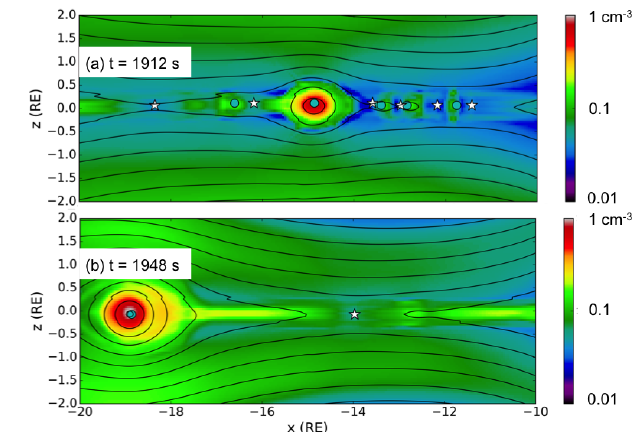
Figure 4. Plasma density in a zoomed area in the tail for (a) t = 1912s and (b) t = 1948s. X points and magnetic islands are marked as in Fig.